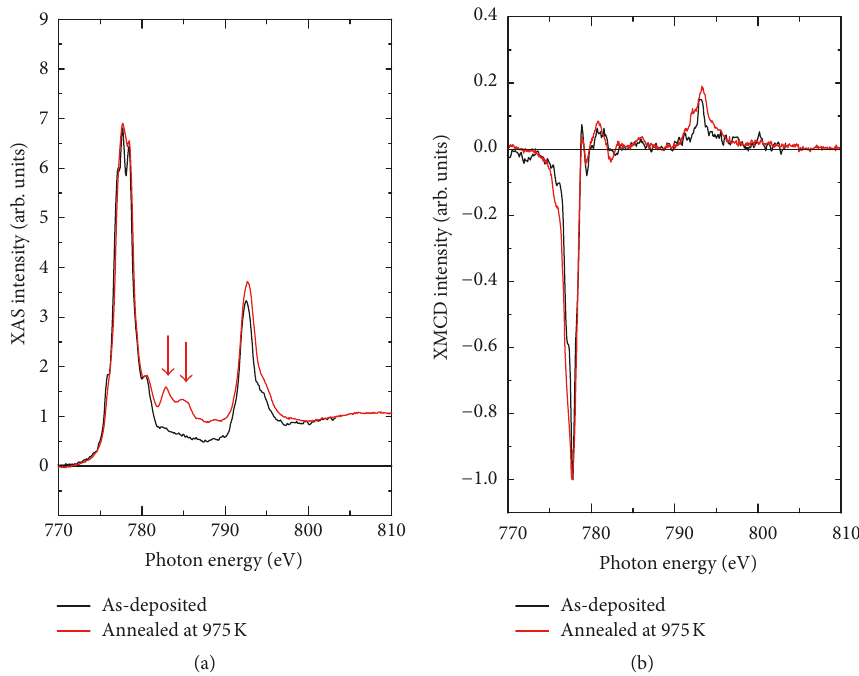
Figure 5: (a) Isotropic FY XAS spectra for the as-deposited (black line) and annealed (red line) Co-doped ITO film. Results recorded at 2 K in an applied magnetic field of 4T. The arrows indicate spectral features that arise after annealing. (b) XMCD spectra for the as-deposited (black line) and annealed (red line) Co-doped ITO film. The new spectral features for the annealed sample are indicated with red arrows. The spectra have been normalized at 𝐿 3